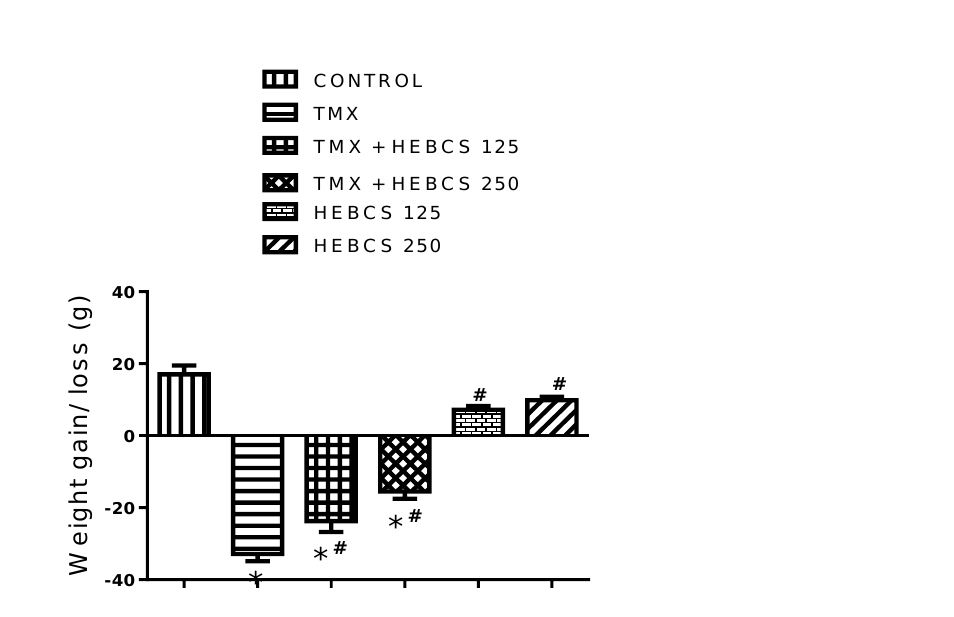
Figure 4. Weight gain/loss in rats following administration of TMX and HEBCS for three weeks. Data are presented as mean ± SD ( n = 6); * p < 0.05 Control versus other groups; # p < 0.05 TMX versus HEBCS groups. TMX: Tamoxifen; HEBCS 125 and 250: Hydroethanolic Extract of Buchholzia coriacea Seeds, 125 and 250 mg/kg body weight.